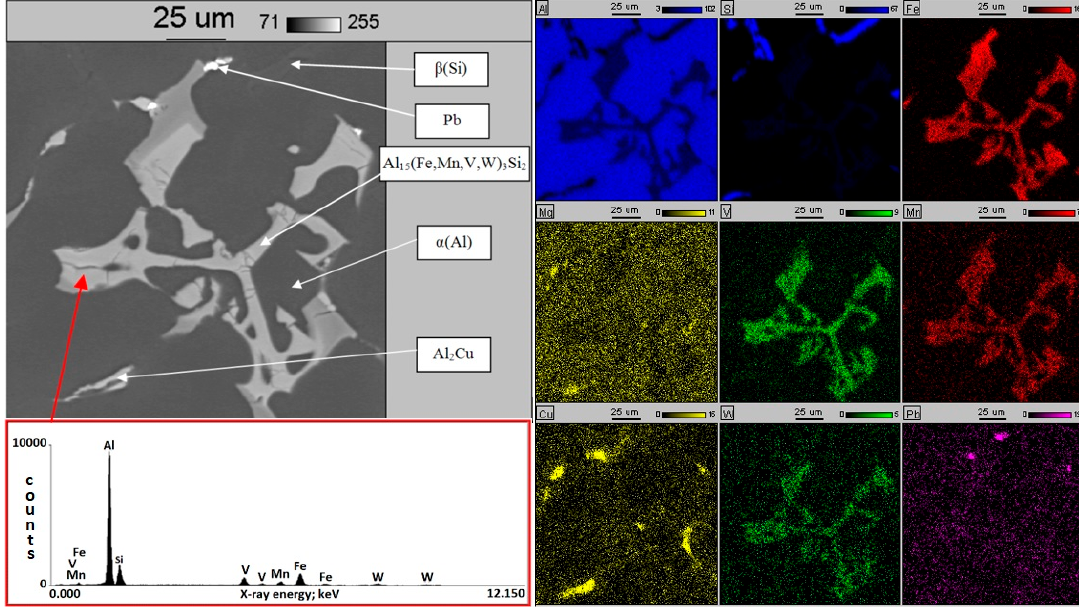
Figure 8. Region of the ternary eutectic in the alloy with ~0.2 wt % V and W from the shell sand probe and the distribution analysis of elements.